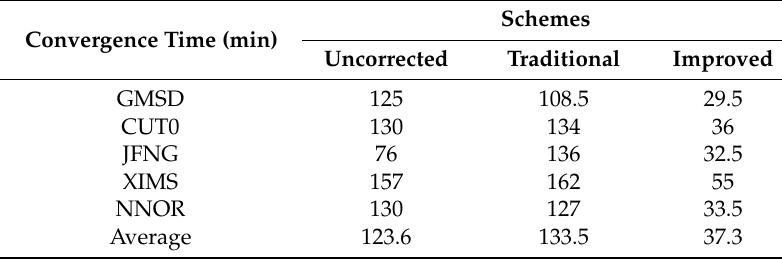
Figure 11. 3D positioning error of the first two hours on CUT0 and JFNG (DoY 047/2014). Table 4. Convergence time under three schemes for five stations.